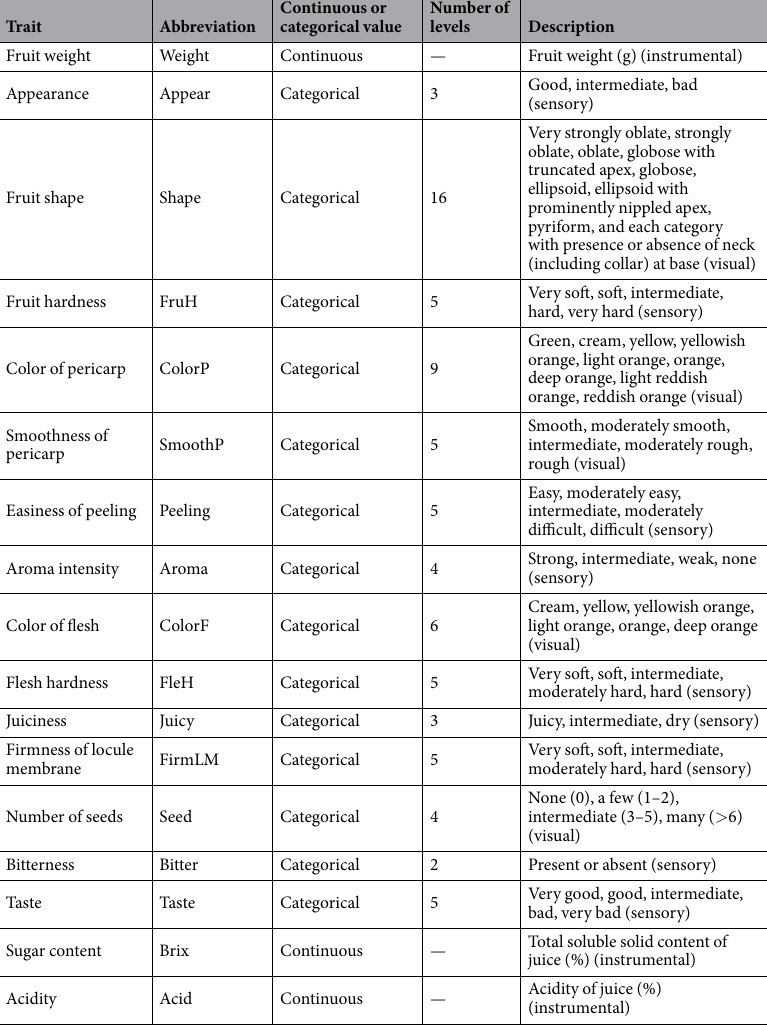
Table S5), several common significant SNPs were detected: seven on chromosomes (Chr.) 2, 4, and 6 for ColorP and ColorF ( r = 0.81) and three on Chr. 3 for FruH and Peeling ( r = 0.76). Single common significant SNPs were detected for FleH and Juicy (Chr. 4; r = 0.68); FirmLM and Seed (Chr. 4; r = 0.35); and ColorP, ColorF, and Bitter (Chr. 6). A single common significant SNP for Weight, ColorP, Bitter, and Acid (Chr. 4) is consistent with the largest (although not significant) peak SNP for sugar content (Brix). Two genes, Ciclev10031587 m.g and Ciclev10031003 m.g, were found between the significant SNPs on Chr. 4 for ColorP and ColorF; these genes were located 490 kb and 17 kb apart from the nearest significant SNPs, respectively, within a high-LD region (Supplementary Fig. S7). These genes are annotated as phytoene desatura- tion 1 ( pds1 ) and carotenoid cleavage dioxygenase 4 ( ccd4 ), respectively. A significant SNP on Chr. 3 for FruH and Peeling resided in the gene Ciclev10018456 m.g, which is annotated as callose synthase . This gene was also located in the region flanking a significant SNP for FleH. The common significant SNP on Chr. 4 for Weight, ColorP, Bitter, and Acid resided in the gene Ciclev10031681 m.g, which is annotated as glutamate dehydrogenase . Accuracy of prediction models for 17 fruit traits in the parental population. Ten-fold CV showed that prediction accuracy was high for Weight, FruH, ColorP, Peeling, ColorF, and FirmLM ( r ≥ 0.7), intermediate for fruit shape (Shape), smoothness of pericarp (SmoothP), Aroma, FleH, Juicy, Seed, Bitter, taste (Taste), Brix, and Acid (0.3 ≤ r < 0.7), and low for appearance (Appear) ( r < 0.3) (Fig. 4A). GBLUP (RR and GAUSS), Ridge Regression, and Bayesian regressions were more accurate for most traits than the other methods, whereas the